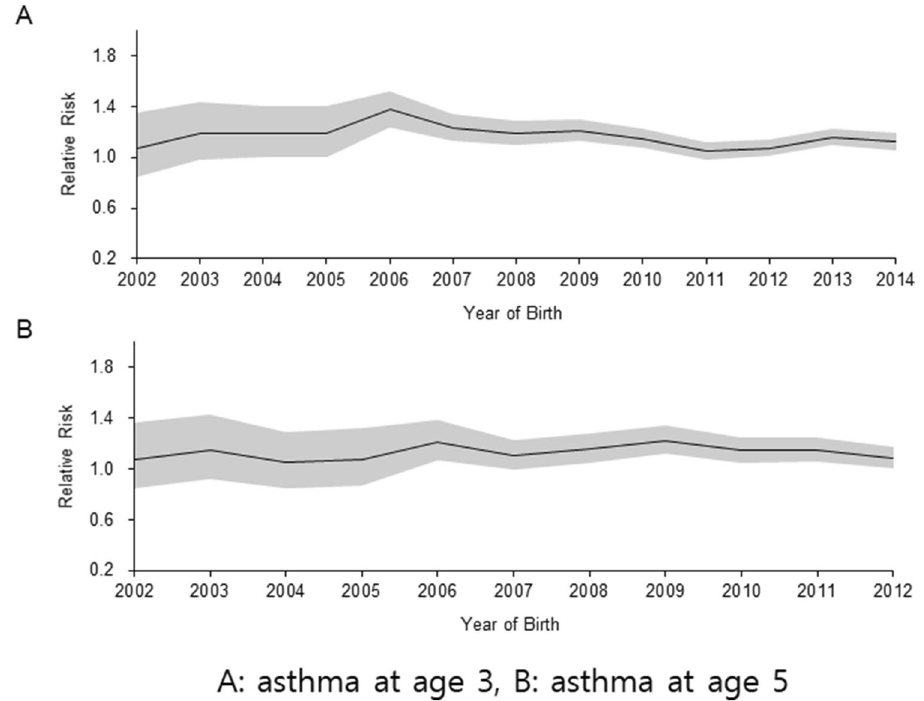
Figure 2. Relative risk of bronchopulmonary dysplasia on asthma diagnosis at ages 3 ( A ) and 5 ( B